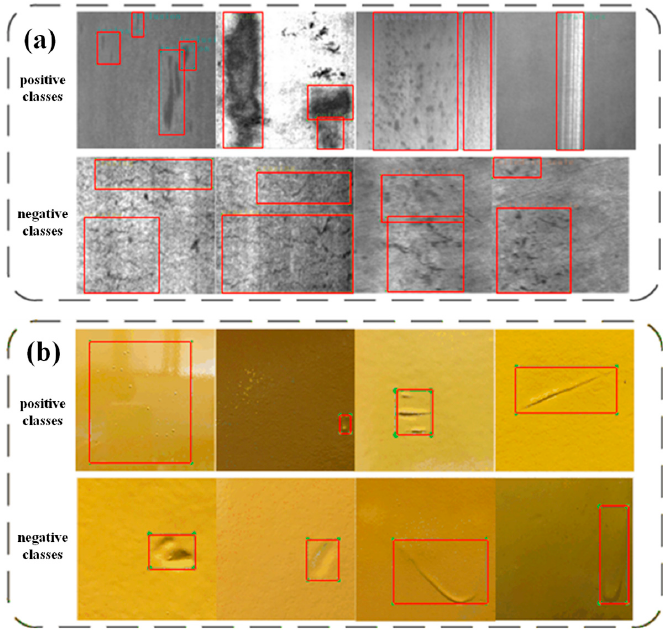
Figure 4. ( a ) Example of NEU division ( b ) Example of Paint division.